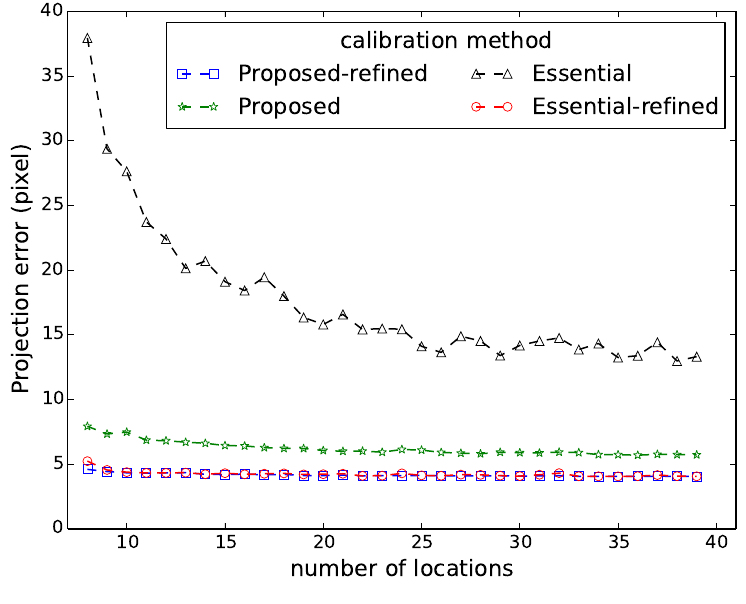
Figure 7. Projection error comparison between our method (proposed) and the method of Hödlmoser et al. [17] (essential) using different numbers of locations. Each location yields two calibration samples (head and